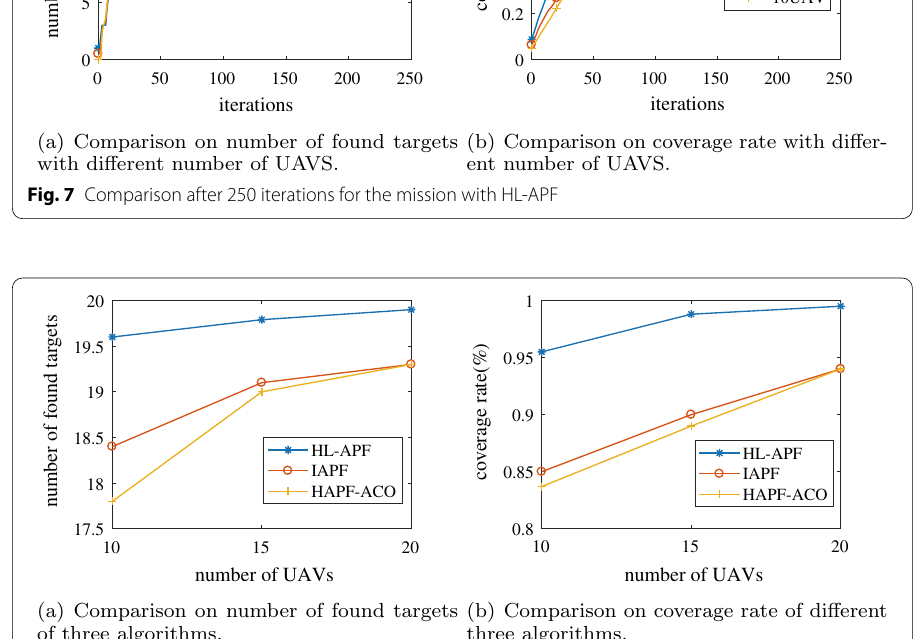
(a) Comparison on number of found targets of three algorithms. Fig. 8 Comparison after 250 iterations for the mission of three algorithms with different number of